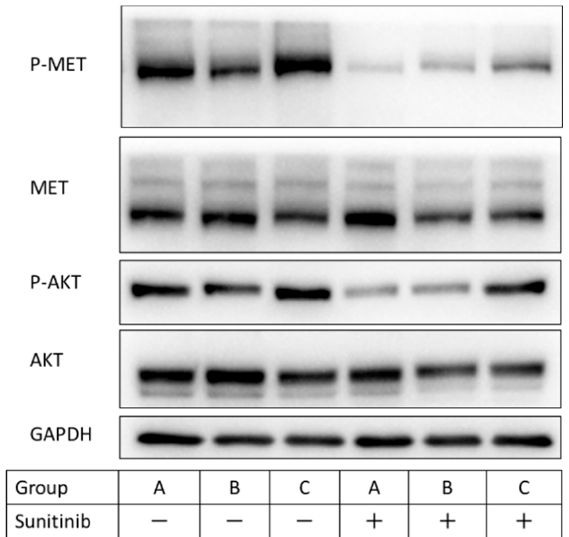
Figure 3. Comparison of the activation pattern of the signal transduction system in sunitinib-resistant cells by western blotting. Group A (P/ − ) was subcutaneously transplanted with 786-P and did not receive sunitinib, group B (P/+) was subcutaneously transplanted with 786-P and received sunitinib treatment, and group C (R/+) was subcutaneously transplanted with 786-R and received sunitinib treatment in vivo. Primary cultured cells were obtained from these mouse models, the cells in each group were cultured in medium with or without sunitinib 5 µ M for 48 h. In a series of western blot analyses, at least three independent experiments were performed with similar results.